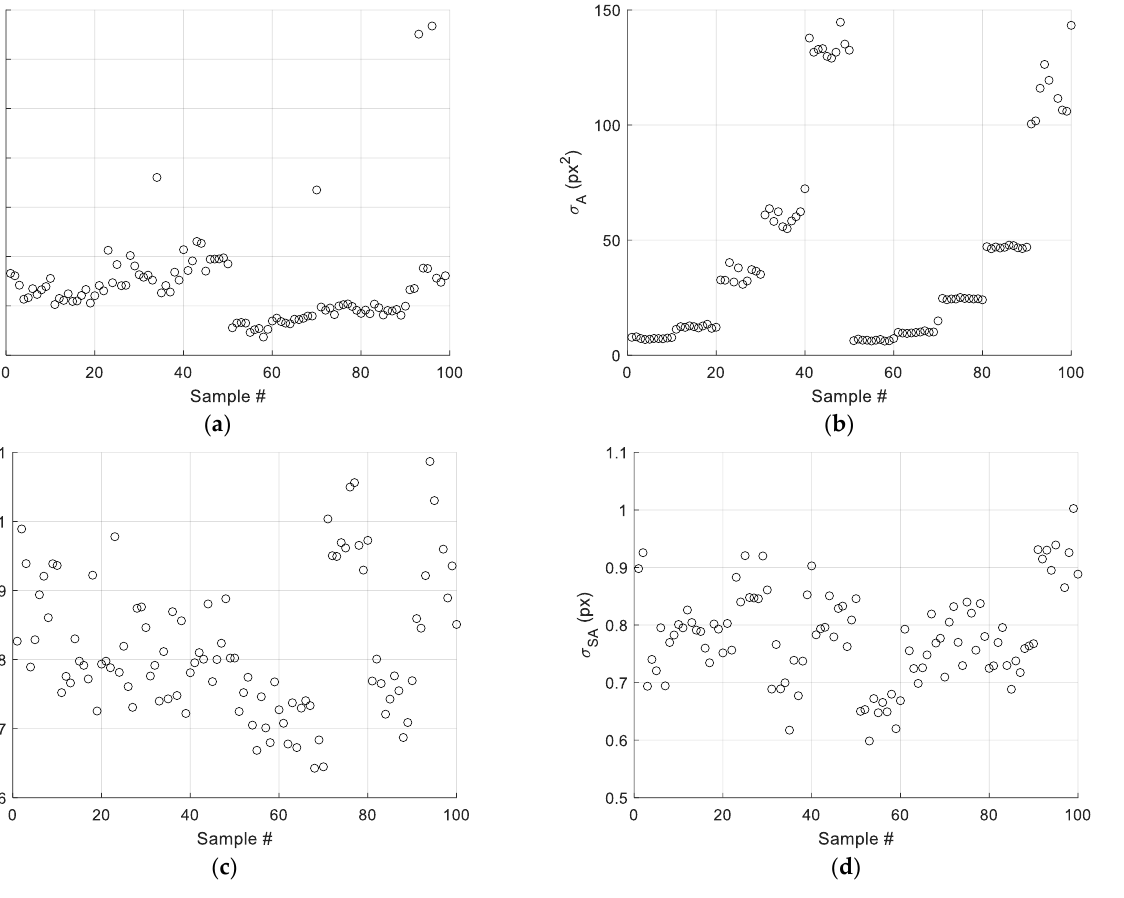
Figure 8. Standard deviation observed during the repeatability test over the considered particle dimensions for ( a ) perimeter, ( b ) area, ( c ) long and ( d ) short axis.